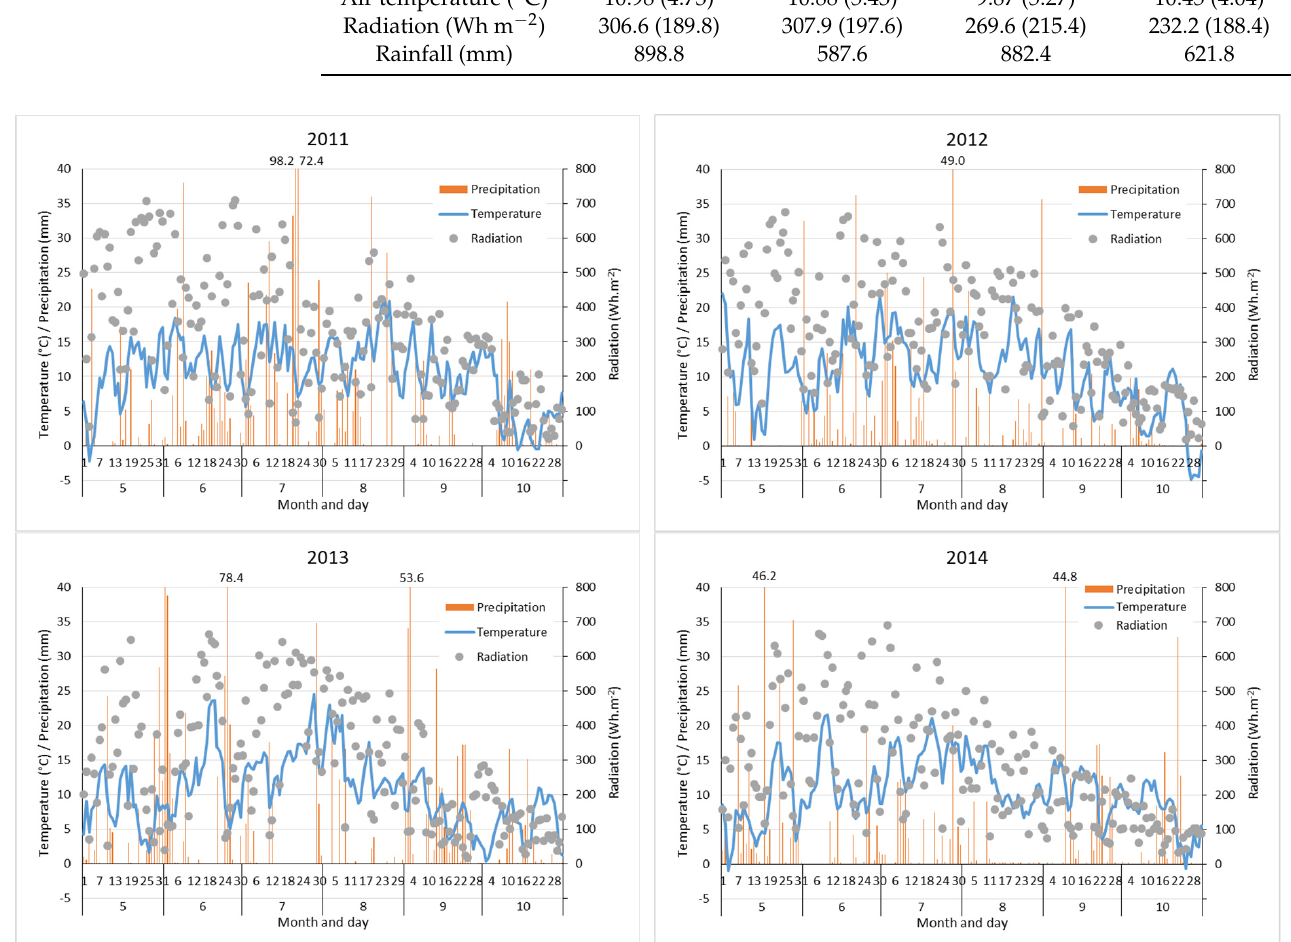
Figure 2. Mean daily air temperature and daily radiation sum (measured every hour) at 200 cm above ground and the daily sum of precipitation in the 2011–2014 growing seasons. Any precipitation value excessing the y -axis range is presented